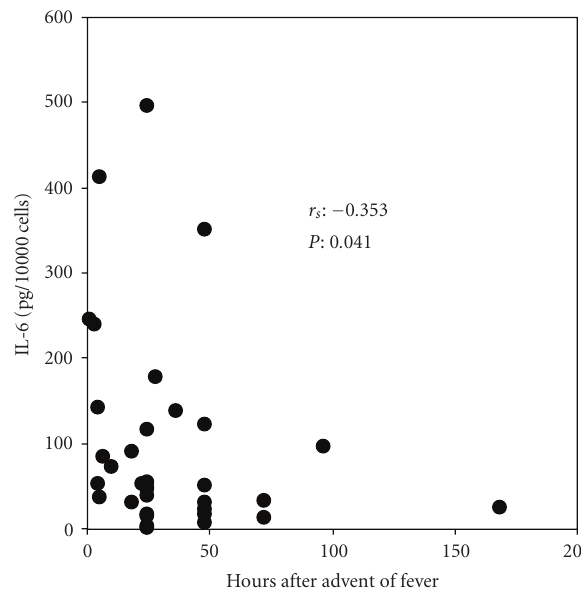
Figure 3: Correlation between time lapsing from advent of fever to blood sampling and concentrations of interleukin-6 (IL-6) released from monocytes of 51 septic patients incubated in the presence of patients’ serum.